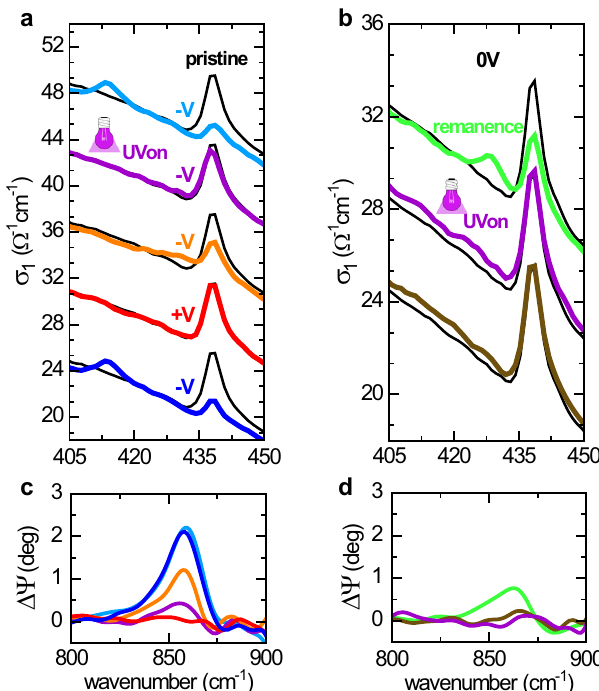
Fig. 4 Optical switching of the anomalous polarization in AlO x /SrTiO 3 at 10 K. a Infrared spectra showing that the pronounced R-mode spitting at − 8 kV/cm (cyan) can be erased by UV illumination (violet) and is only partially restored after the illumination (orange). The original R-mode splitting is restored after a fi eld cycle to + 8 kV/cm (red) and back to − 8 kV/cm (blue). b Infrared spectra at 0 V showing that the remnant R-mode splitting (green) is erased by the UV light (violet) even after it has been turned off again (brown). c , d Corresponding infrared spectra of the polarization-induced TO mode at the LO 4 edge. Shown are the difference spectra of the ellipsometric angle Ψ with respect to the pristine state at 0 V, i.e. ΔΨ = Ψ exp – Ψ 0V, pristine . The data are smoothened with a FFT fi